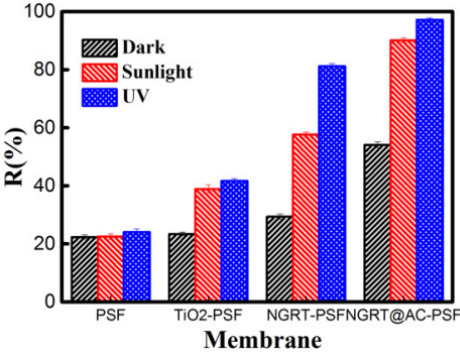
Figure 10. The MO rejection rates by all membranes under dark, sunlight, and UV conditions.